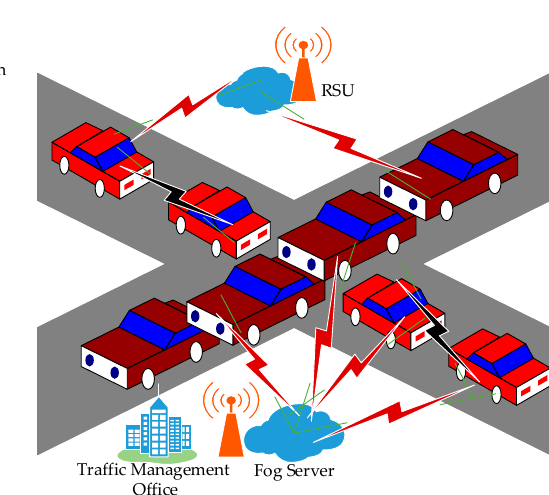
Figure 2. Intrusion/attacker model. Figure 2. Intrusion / attacker